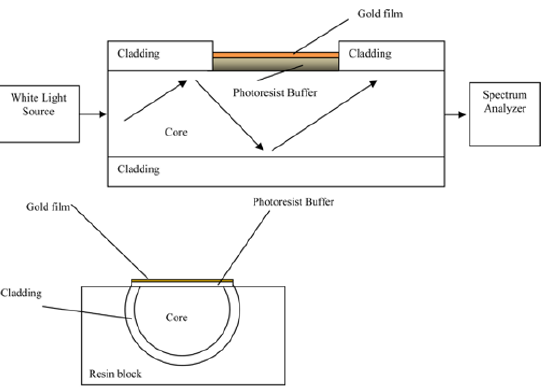
Figure 2. SPR sensor scheme. Reprinted with permission from [48] under an Open Access Creative Commons CC, license 4.0, to MDPI.